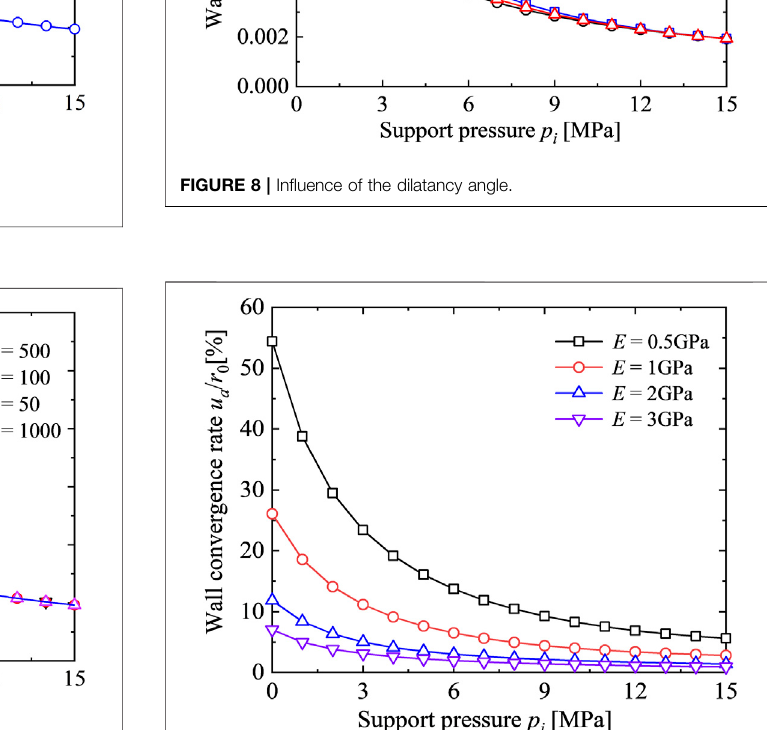
FIGURE 9 | In fl uence of the elastic